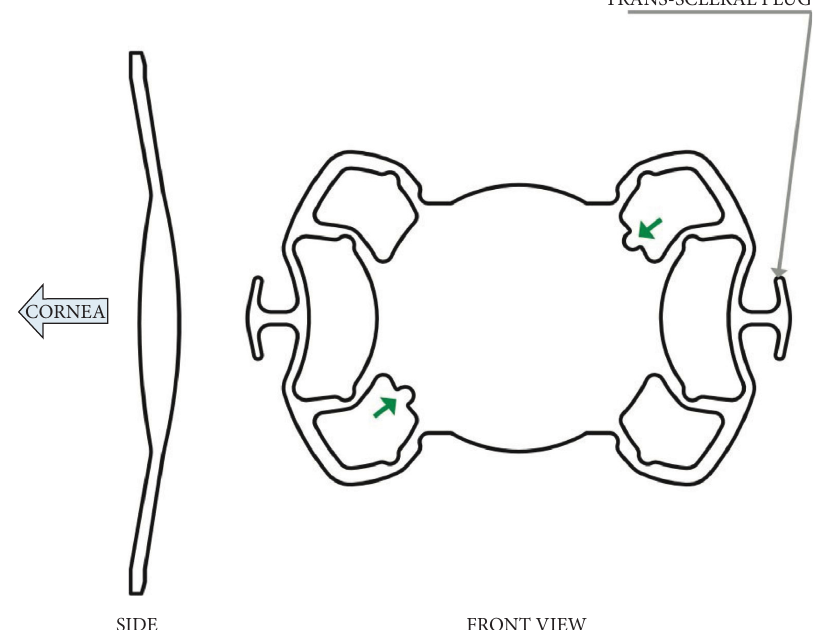
Figure 1: Demonstration of the single-piece SSF-IOL Carlevale Lens.